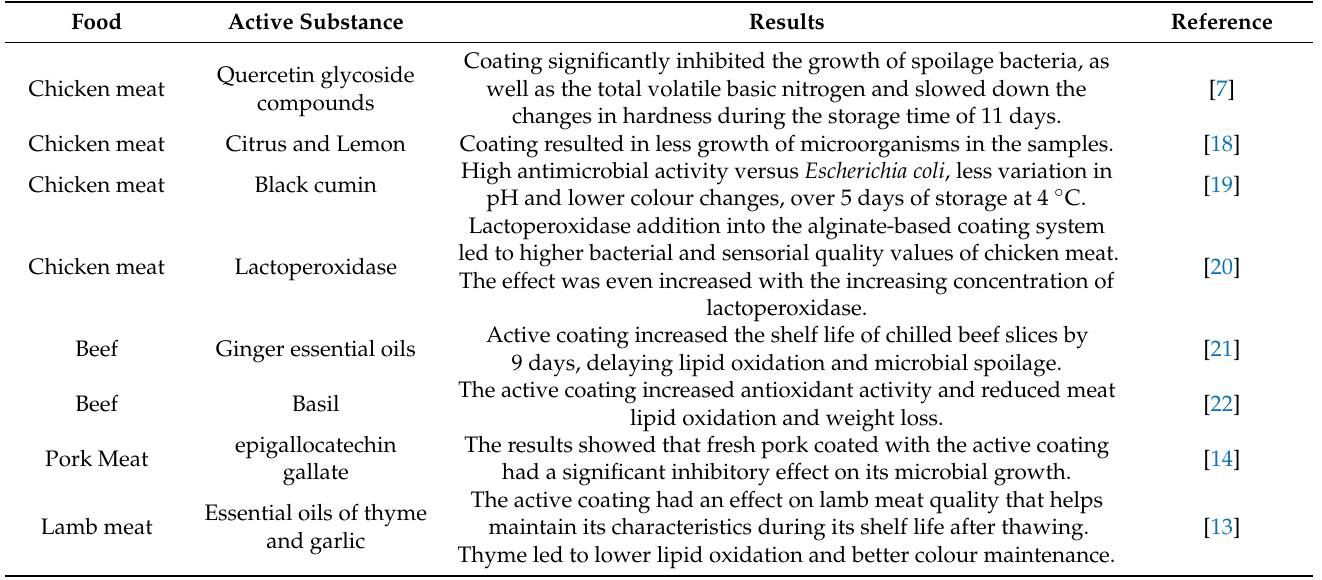
Table 1. Recent applications of active alginate-based coatings in fresh meat and different types of meat